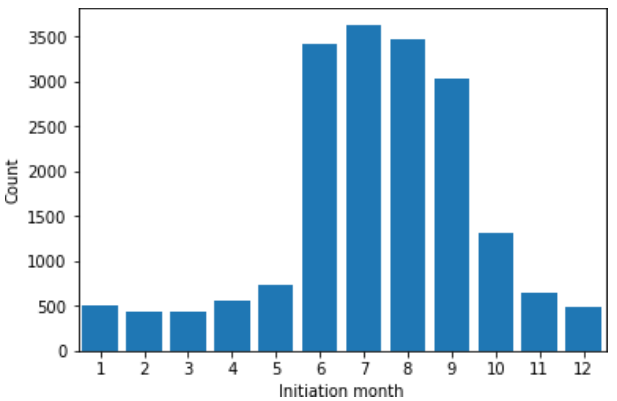
Figure 10. Total number of isolated convective cells that initiated within a 200km range of the KHGX radar during 2015–2017 by month.